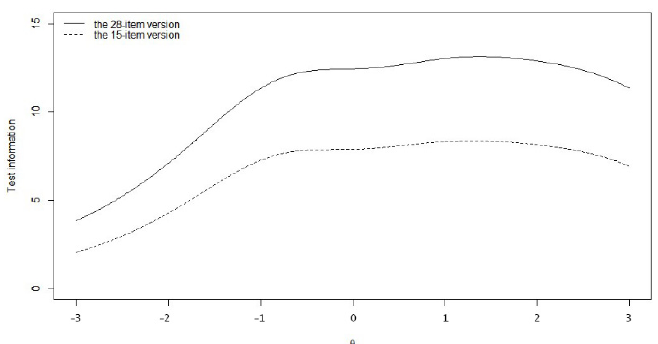
Figure 3. Test information of the initial and final version of D scale.